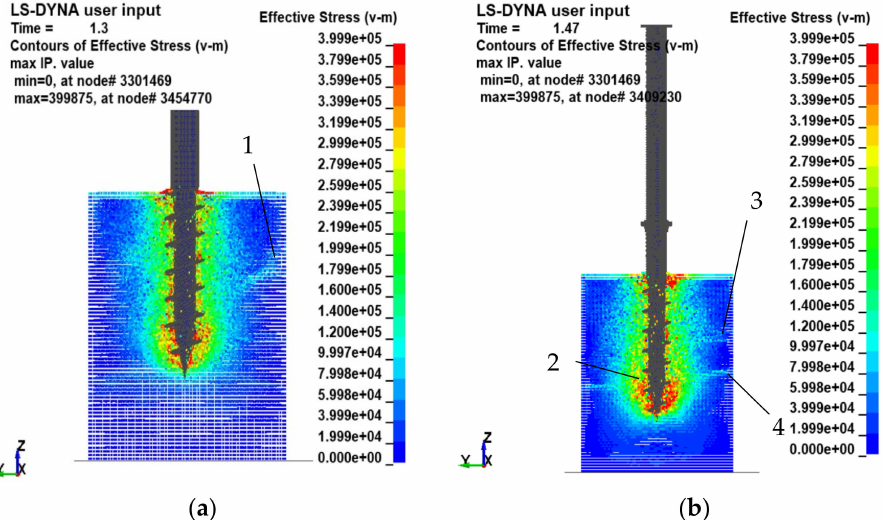
Figure 2. Finite element simulation of pile–soil installation process: ( a ) Original pile; ( b ) Ex- tended